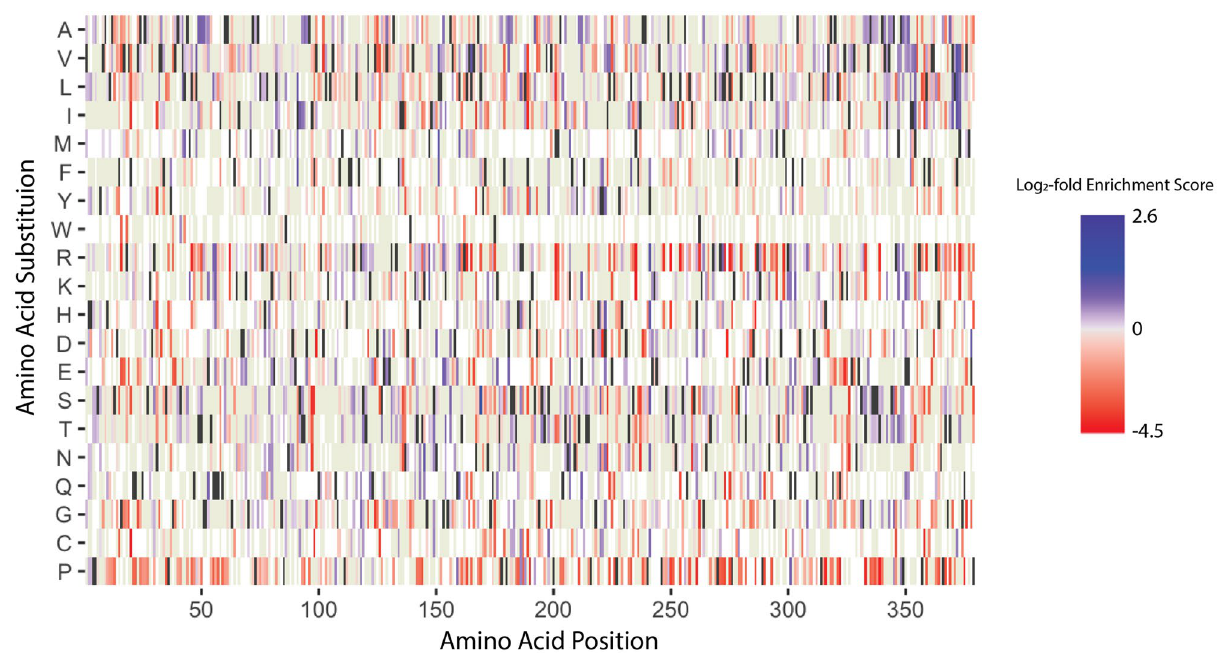
Figure 5. phPAI-1 mutational libraries contain missense variants that result in loss of function. Amino acid position is indicated on the x-axis, while amino acid substitutions are indicated on the y-axis. Loss of function missense variants, as well as those with a reduced capacity to inhibit uPA, are shown in red with shading as a function of their log 2 -fold score, while variants in blue retain PAI-1 inhibitory function. The intensity of shading scales with the degree of enrichment or depletion. WT amino acid residues are shown in black, while beige indicates missense mutations that were present in the mutational library but did not meet significance thresholds. White indicates amino acid substitutions that were not present in the mutational library. This figure was generated using Adobe Illustrator 2021 version 25.2.3 and the ggplot2 package version 3.3.3 for RStudio version 1.4.1106.